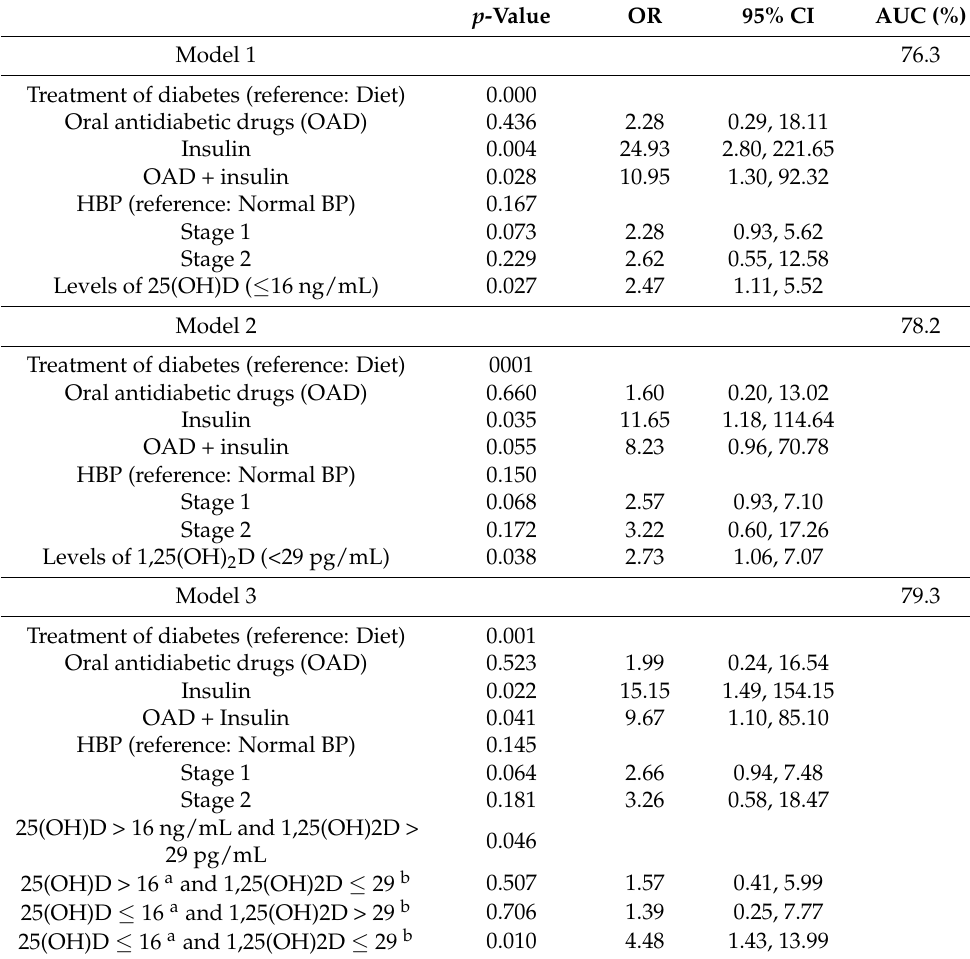
Table 4. Multivariate analysis